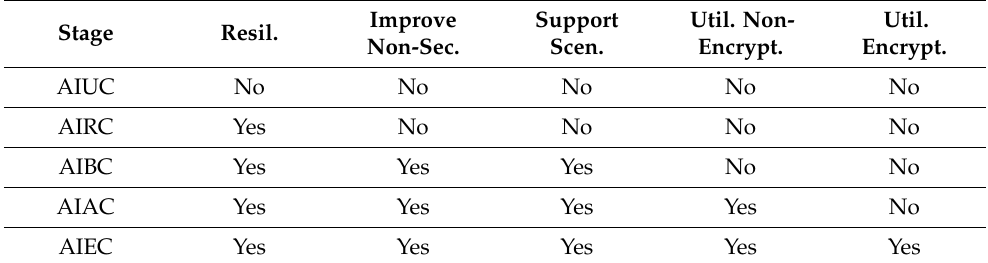
Table 1. Summary of AIIC Evolutionary States. Stage Resil.